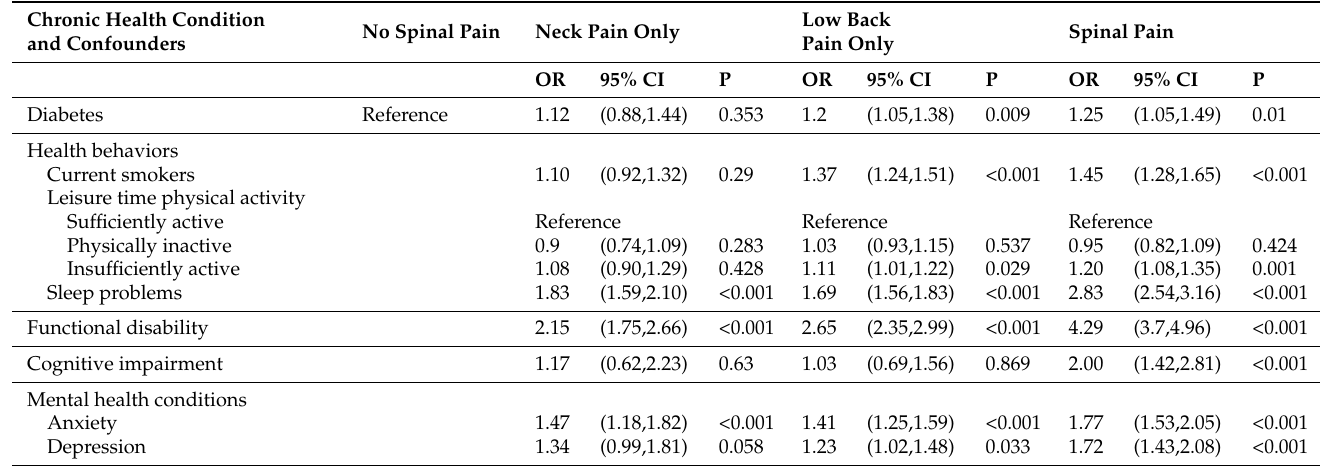
Table 4. The associations between diabetes and spinal pain variables in the US adult population, 2016–2018 *.